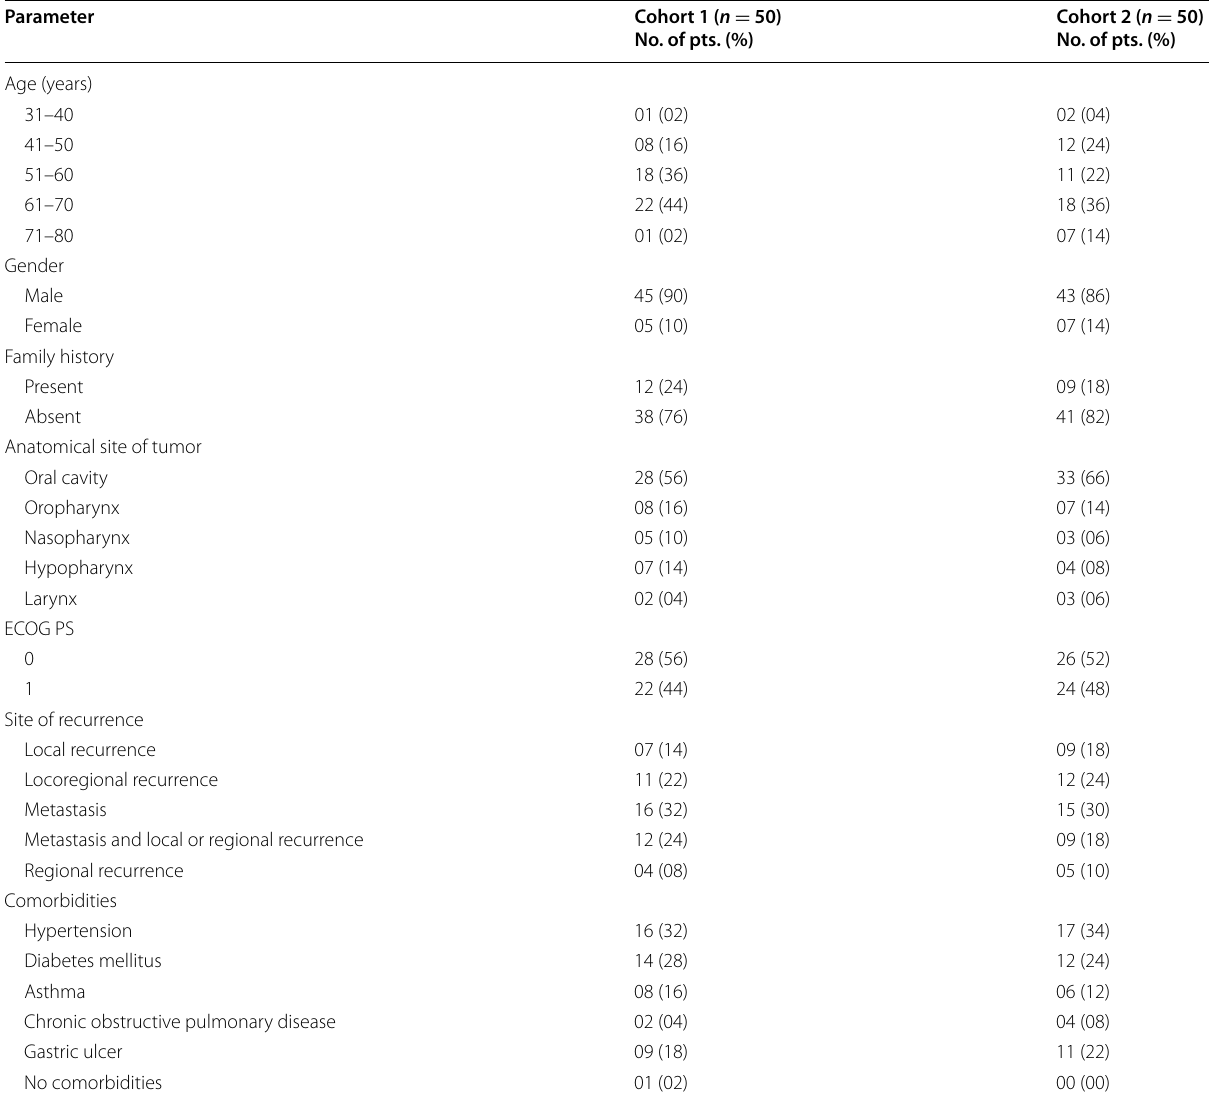
Eastern Cooperative Oncology Group ( ECOG ), performance status ( PS )